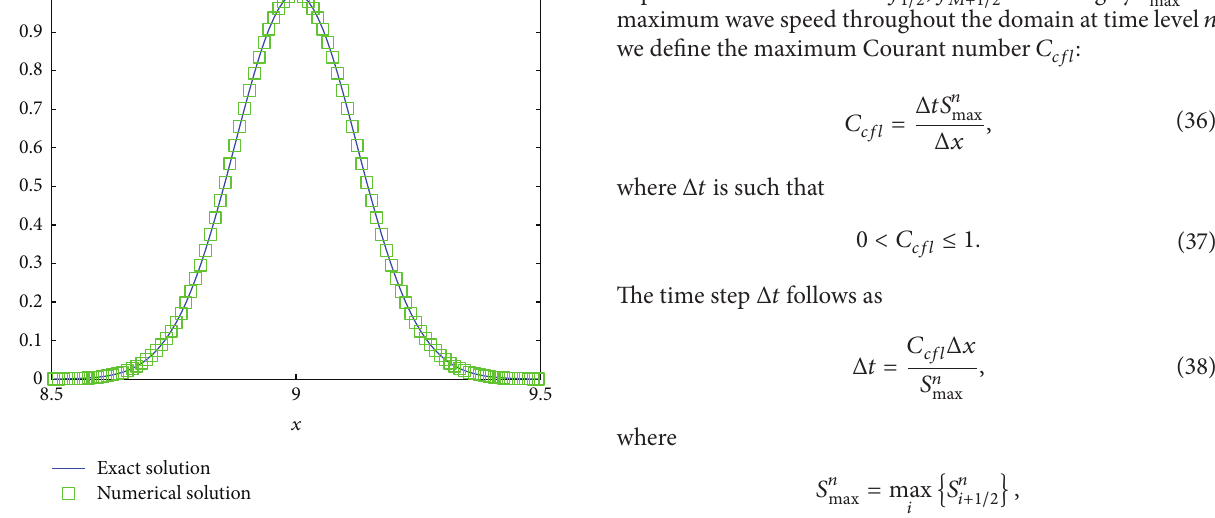
Figure 5: SHA method with TVD (27b) applied to linear advection equation with a continuous initial value; numerical (symbols) and exact (line) solutions are compared at 𝑡 = 9 units.